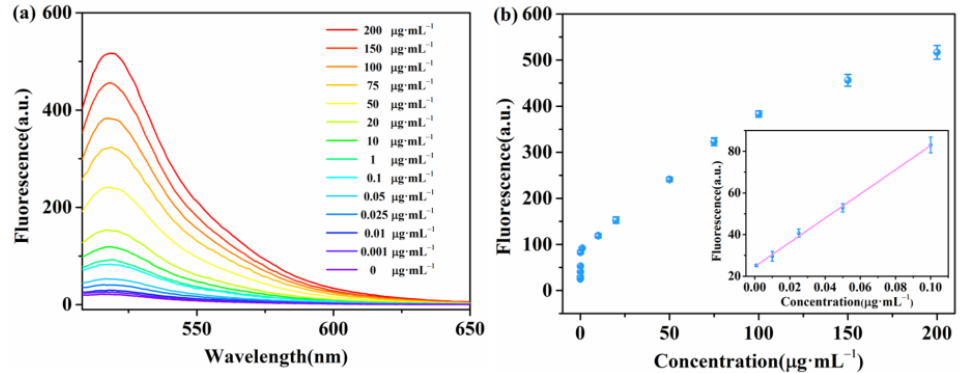
Figure 4. ( a ) Fluorescence emission spectra of β-Lg aptamer at different concentrations of β-Lg (from a to n: 0, 0.001, 0.01, 0.025, 0.05, 0.1, 1, 10, 20, 50, 75, 100, 150, and 200 μg·mL −1 ). ( b ) The standard curve of β-Lg. Insert: linear fitting of fluorescence intensity versus target β-Lg concentration at 518 nm.